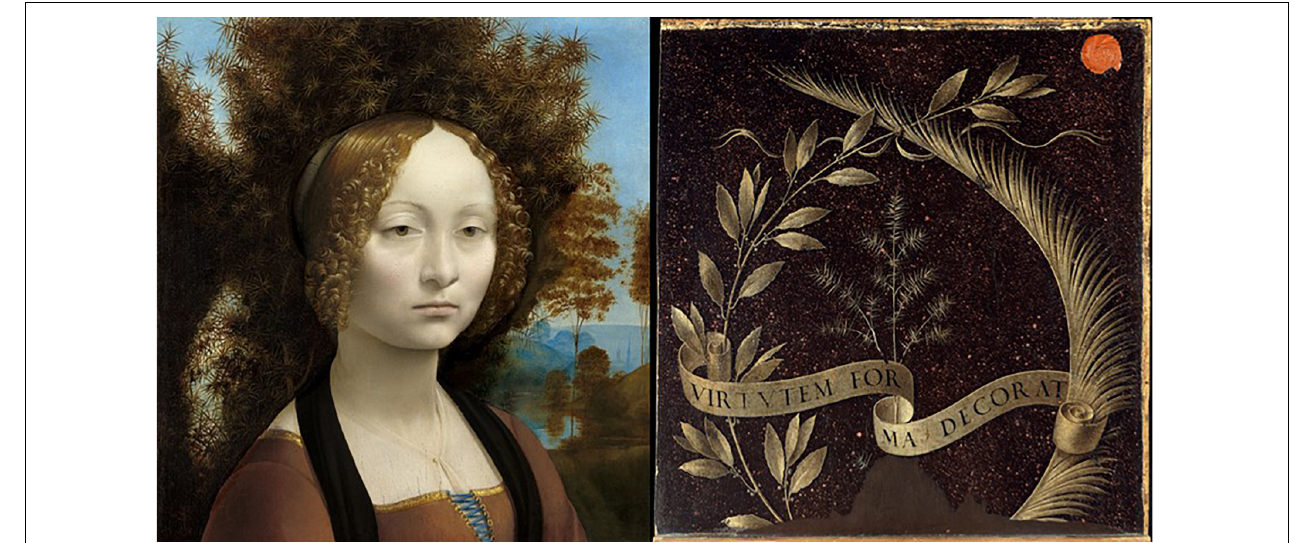
FIGURE 1 | Leonardo da Vinci’s portrait of Ginevra de’ Benci and the reverse side of the painting.